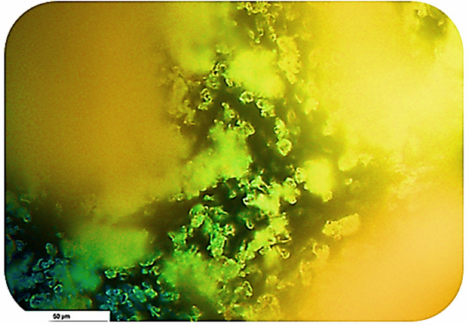
Figure 3. High magnification optical microscope image of RHs